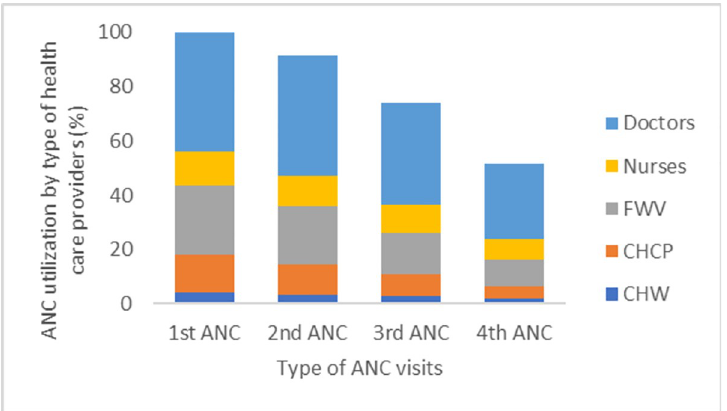
Fig 3. ANC utilization by health care providers. CHW (Community Health Workers: FWA, HA, others; FWV (Family Welfare Visitor); CHCP (Community Health Care Provider).